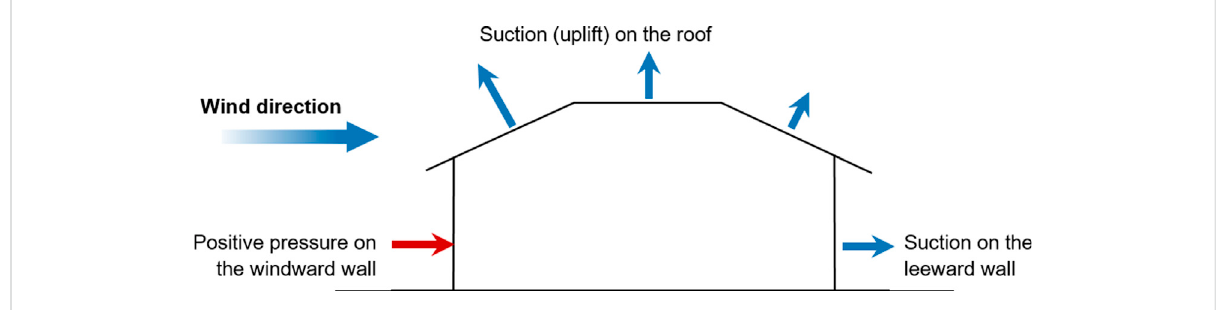
FIGURE 1 Typical external pressures on a sealed building.